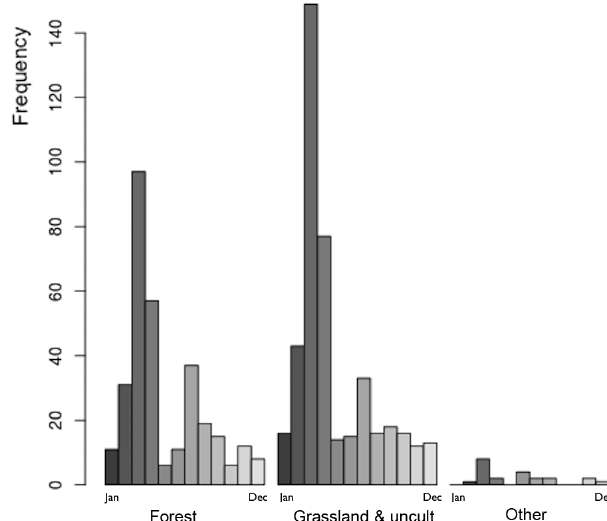
Figure 4. Frequency of fire ignitions by month and vegetation cover type.